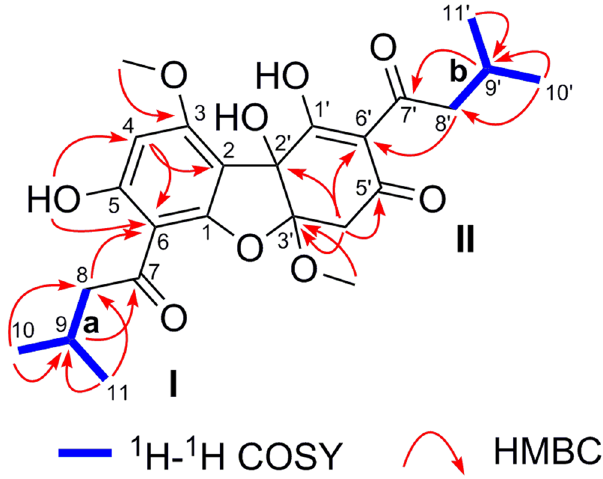
Figure 2. The key 1 H- 1 H COSY and HMBC correlations (H → C) of 1